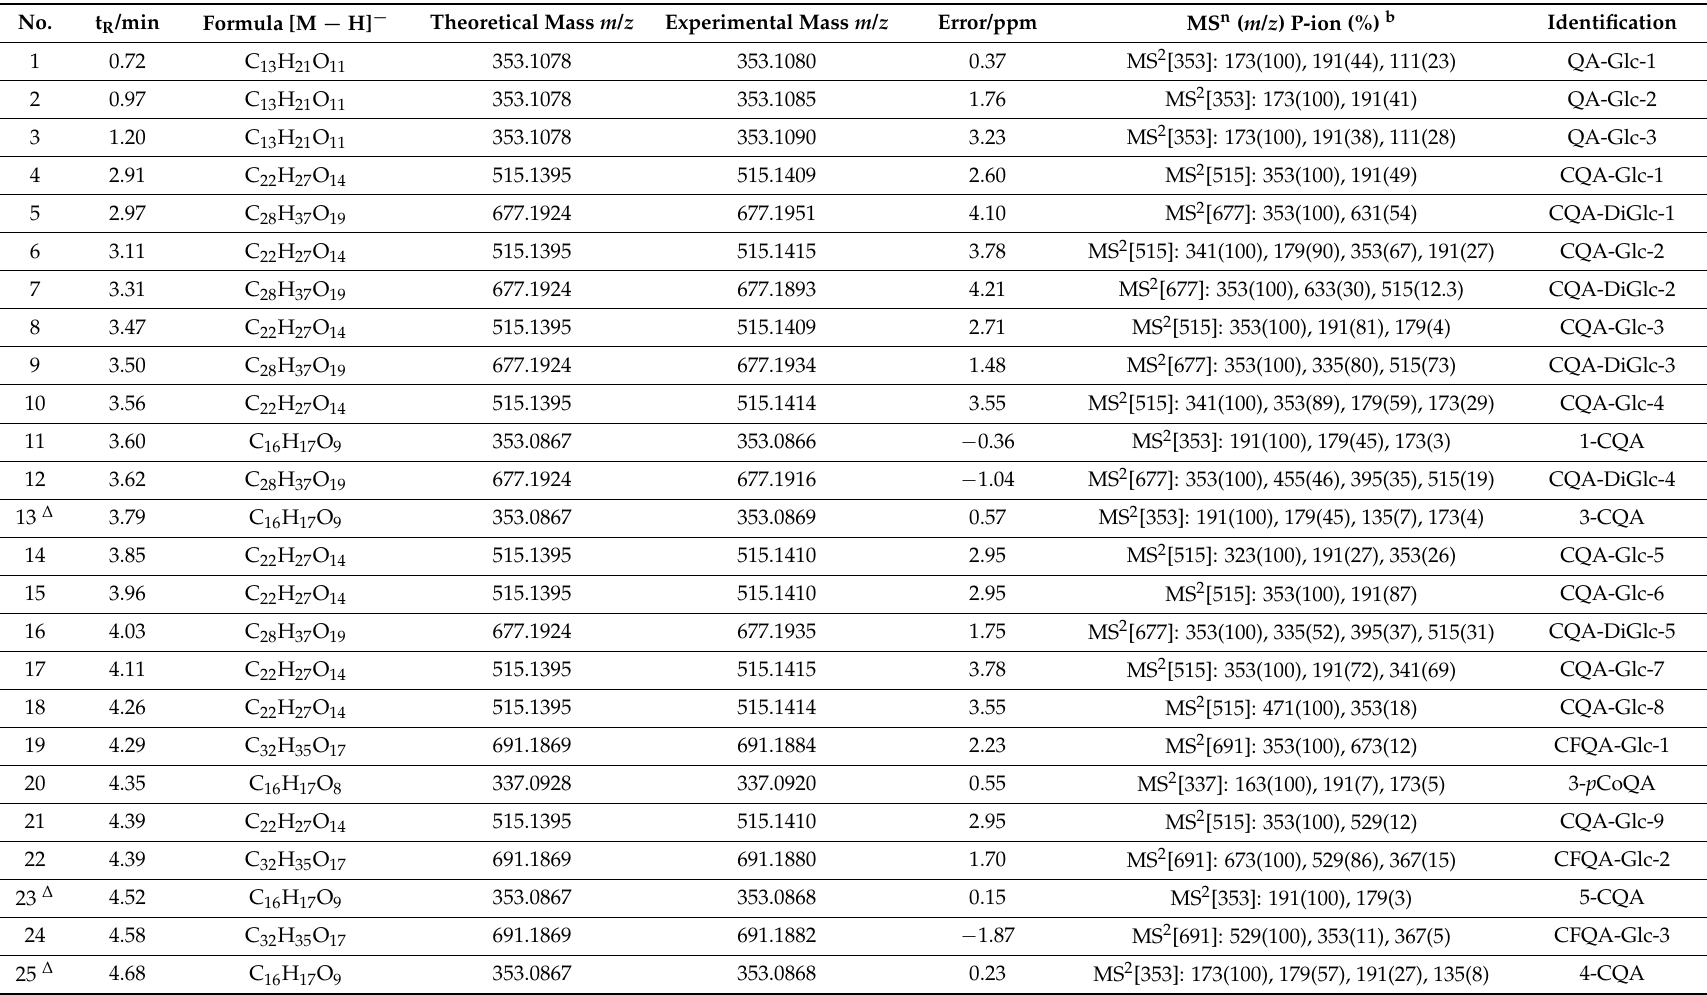
Table 4. Characterization of CGAs in Kuding tea using UHPLC-DAD-LTQ-Orbitrap